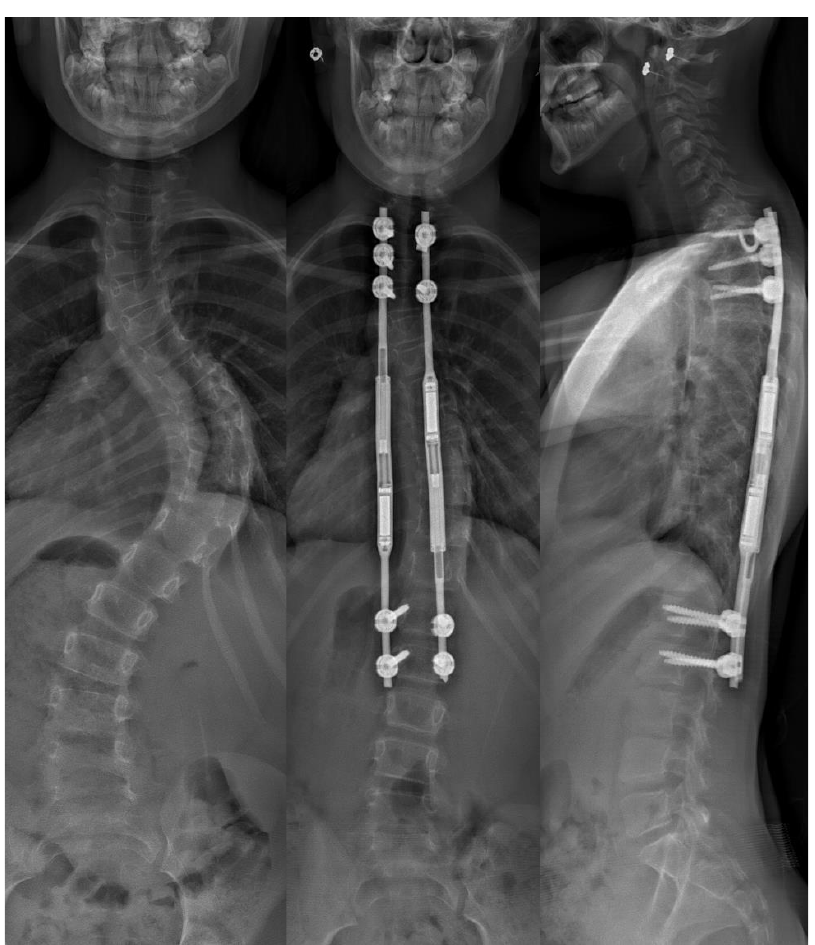
Figure 3. Left: preoperative of large magnitude scoliosis, Center: postoperative anterior-posterior radiograph, Right: lateral radiographs following the application of two magnetic growing rods with significant improvement of the curvature.